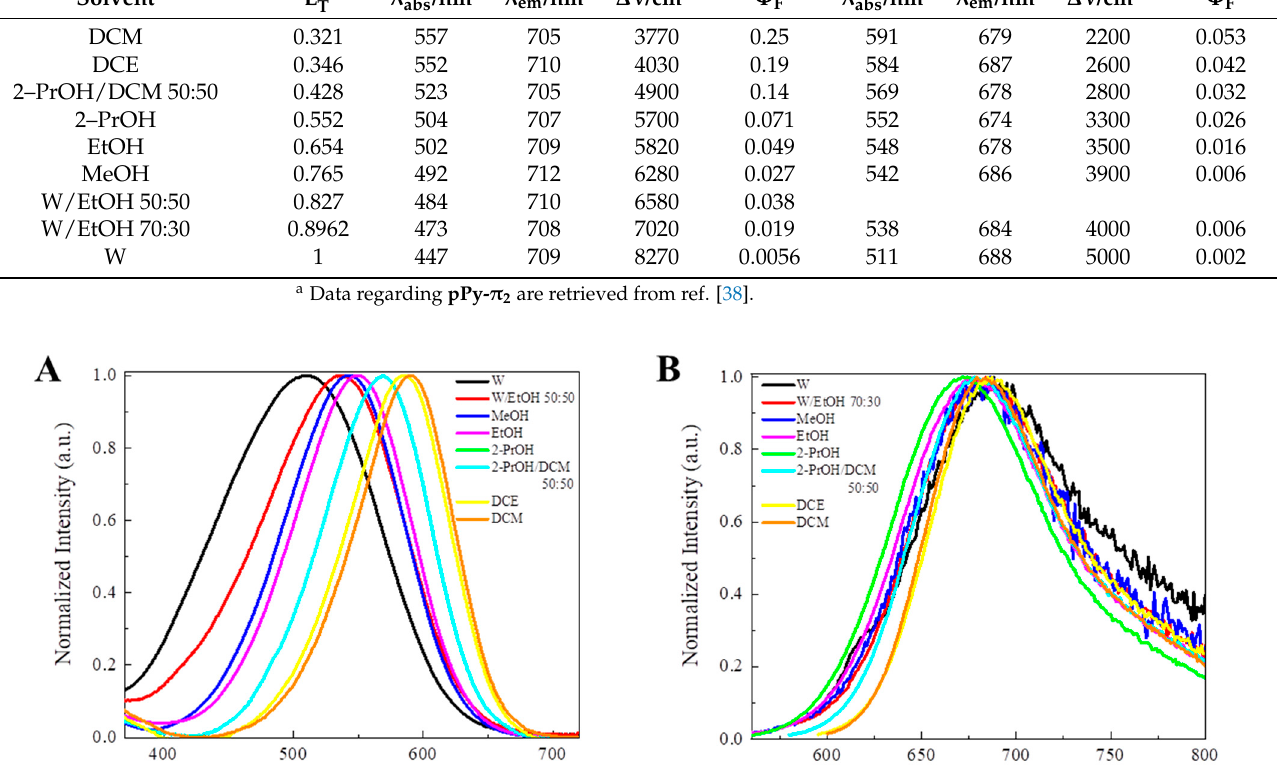
Table 1. Spectral and photophysical properties of the investigated compounds in solvents of dif- ferent polarity (E TN ), absorption maximum ( λ abs ), emission maximum ( λ em ), Stokes shift ( Δν ), and fluorescence quantum yield ( Φ F ). pPy- π 2 a pQ- π 2